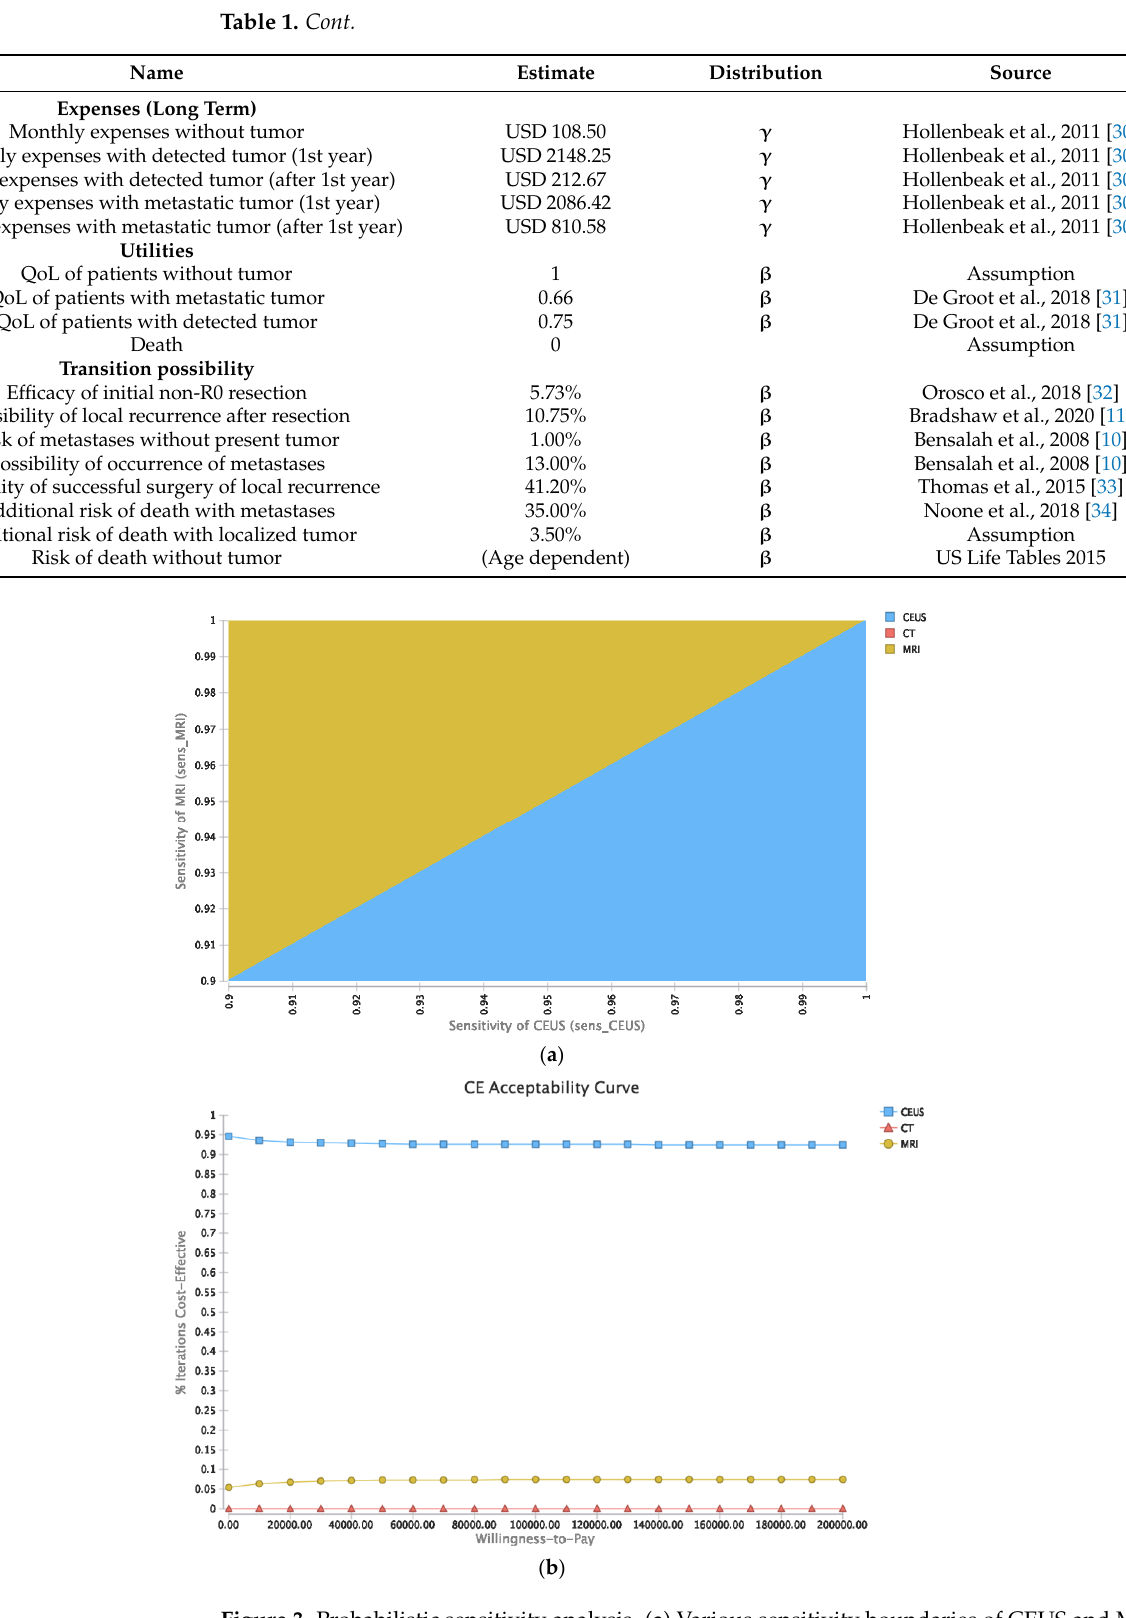
Figure 3. Probabilistic sensitivity analysis. ( a ) Various sensitivity boundaries of CEUS and MRI and their impact on cost-effectiveness at a WTP of USD 100,000/QALY. ( b ) Acceptability of diagnostic strategies out of 30,000 reiterations for different WTP boundaries indicating CEUS as the most economical approach in detection and characterization of solid renal masses.